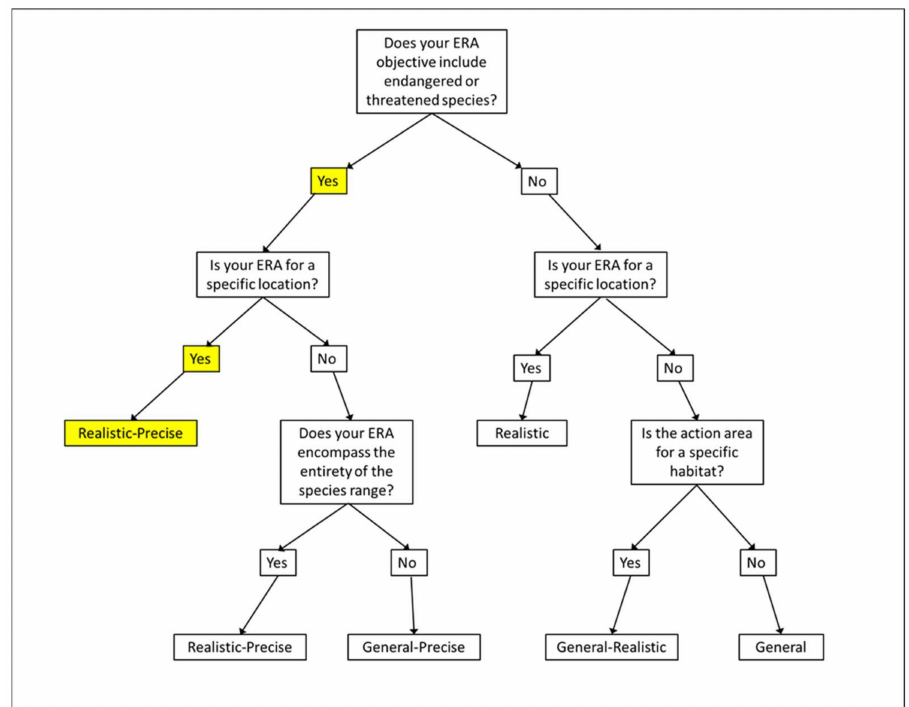
Figure 1. Decision tree taken from Pop-GUIDE. Decisions made for each question are highlighted in